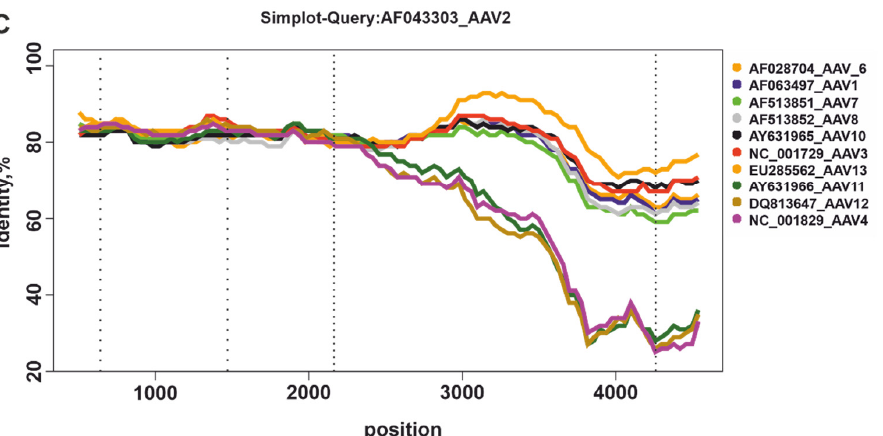
Figure 3. Pairwise amino acid and nucleotide distance plot of AAV A representatives ( n = 103): ( A ) for 453–1700 nt region; ( B ) for 2250–4400 nt region. Each dot corresponds to amino acid and nucleotide distances of one virus pair. ( C ) Similarity plot demonstrate mosaic genome patterns in AAV. Similarity scan was conducted using alignments of eleven nucleotide sequences indicated in the legend with window/step size 1000/40 nt. Dotted lines indicate 453–1700 nt and 2250–4400 nt regions. Table 1. Nucleotide sequence (453–1700 nt positions of full-genome sequence) differences (upper triangle) and inferred amino acid sequence differences (lower triangle) among reference genomes of the currently registered AAV serotypes. Each color indicates a distinct rep genotype based on the nucleotide sequence difference of >10% with representatives of other genotypes and <10% for genomes within a genotype. Nucleotide sequence differences values below 10% (0.10) are highlighted in bold.